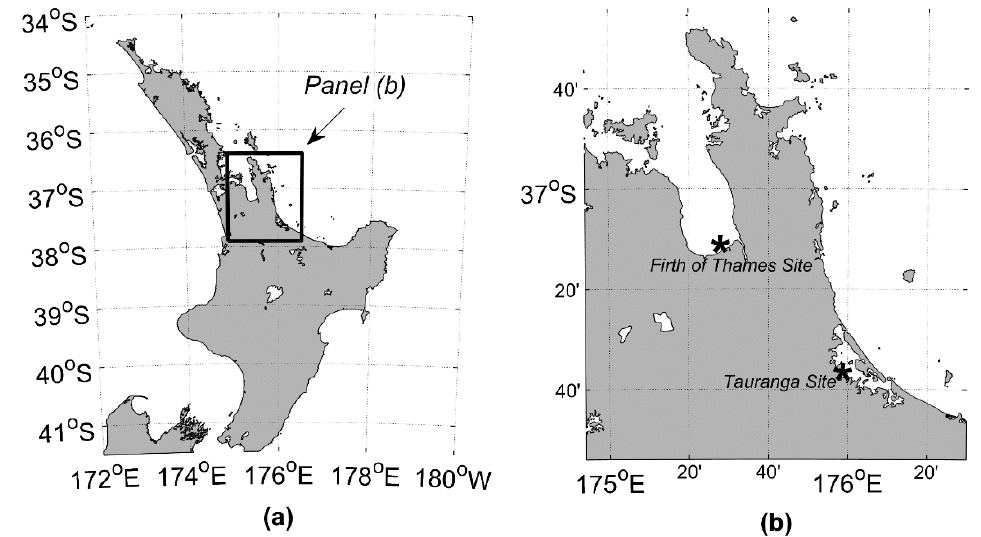
Figure 1. ( a ) The North Island of New Zealand with a panel ( b ) outlined; ( b ) Section of North Island of New Zealand showing the proximity of the Firth of Thames and Tauranga mangrove sites.